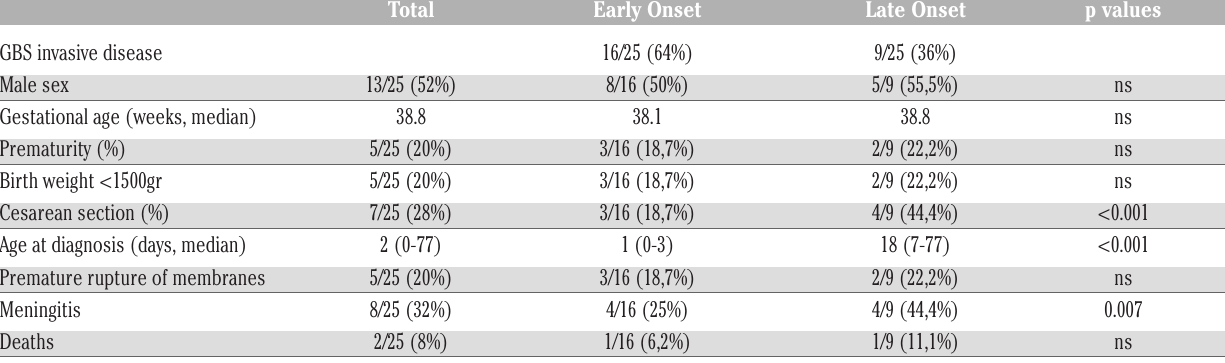
Table 1. Characteristics of infants less than 90 days old with Group B Streptococcus (GBS) invasive